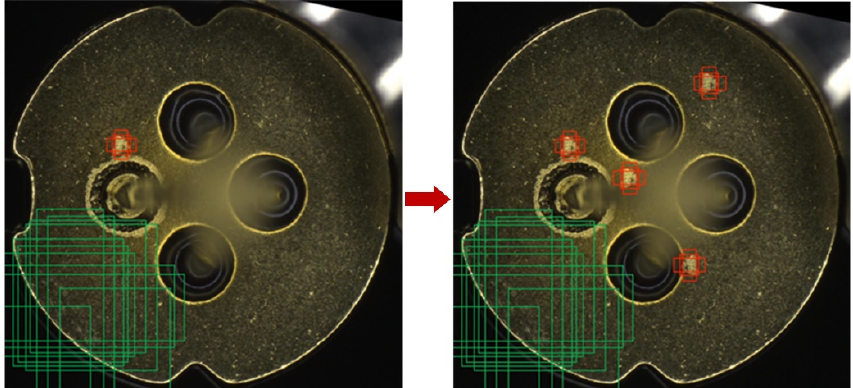
Figure 5. Schematic illustration of anchors matching the ground truth objects.